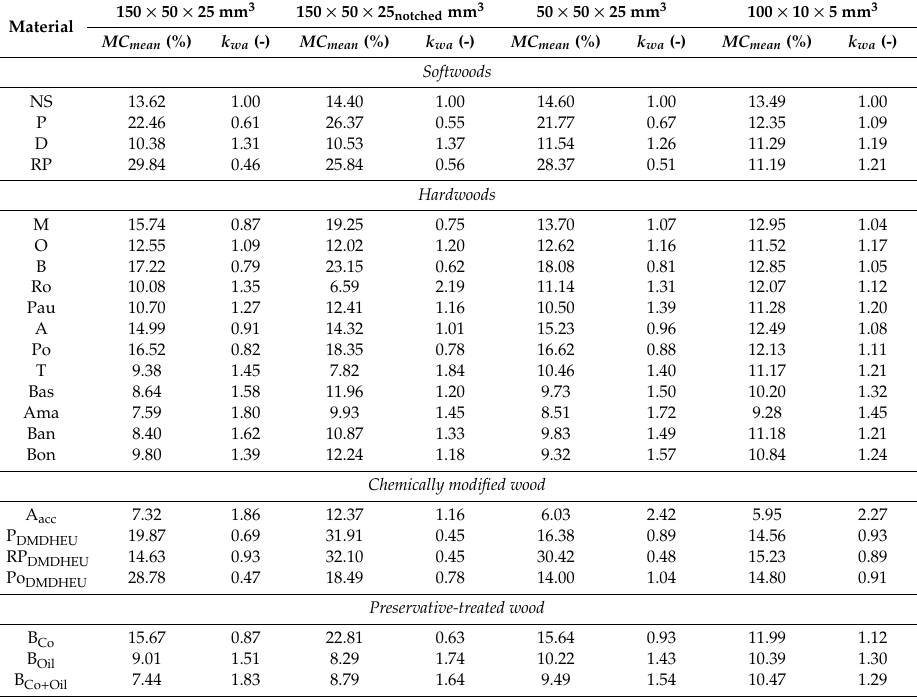
Table 6. Mean moisture content ( MC mean ) of di ff erent softwoods, hardwoods, modified wood and preservative-treated wood detected during free-ventilated horizontal outside exposure (test field in Goettingen, Germany, 51 ◦ 33 (cid:48) 34.9” N, 9 ◦ 57 (cid:48) 18.5” E, elevation: 199 m, oceanic continental climate) between 15 April 2019 and 20 June 2019, depending on the specimen